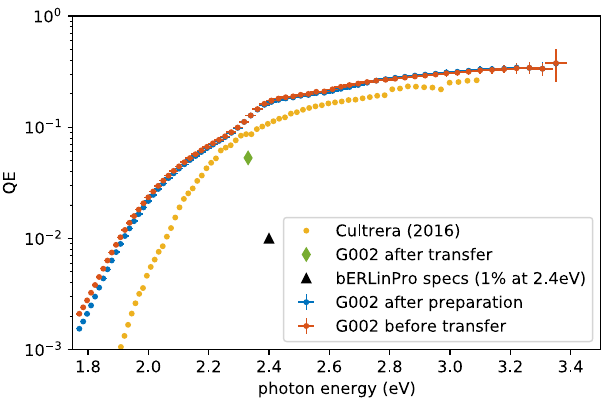
FIG. 7. Spectral response measurements of the Cs-K-Sb photo- cathode (G002) prepared for the SRF photoinjector operation, after preparation (blue) and before transport (red). The green diamond shows the QE after transportation and the black triangle indicates the QE specification for bERLinPro. The reference data was obtained from Cultrera et al.